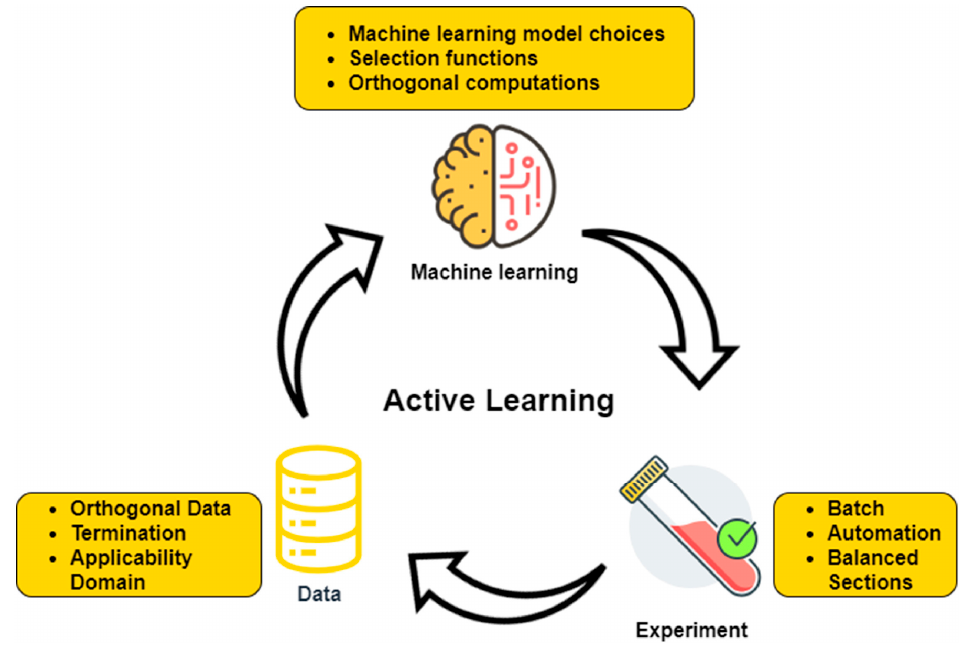
Figure 3. ML in drug discovery. Reproduced from [14] , Elsevier B.V. 2021.